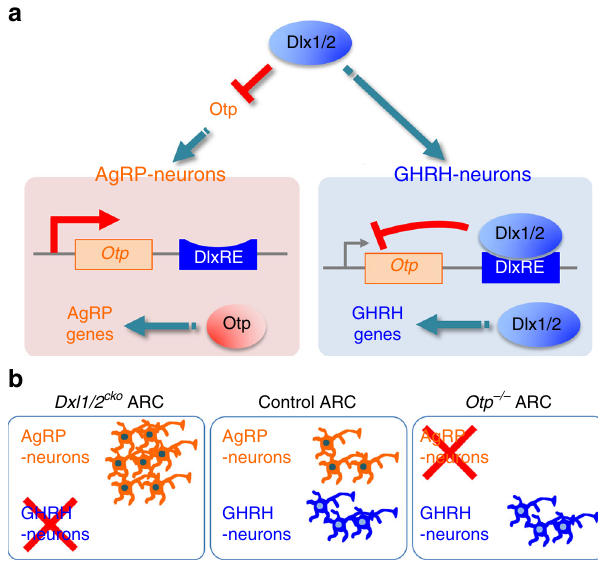
Fig. 7 Our working models. a A balanced production of AgRP- and GHRH- neurons is directed at least in part by the Dlx1/2-Otp gene regulatory axis, by which Dlx1/2 suppress Otp expression in developing GHRH-neurons. It remains to be determined if a similar gene regulatory axis that functions to block developing AgRP-neurons from adopting a GHRH-neuronal fate also exists. Also unclear is how Dlx1/2 and Otp control GHRH- and AgRP- neuronal genes, respectively. b Schematic representation of dysregulated production of AgRP- and GHRH-neurons in Dlx1/2 cKO and Otp − / − mice relative to control